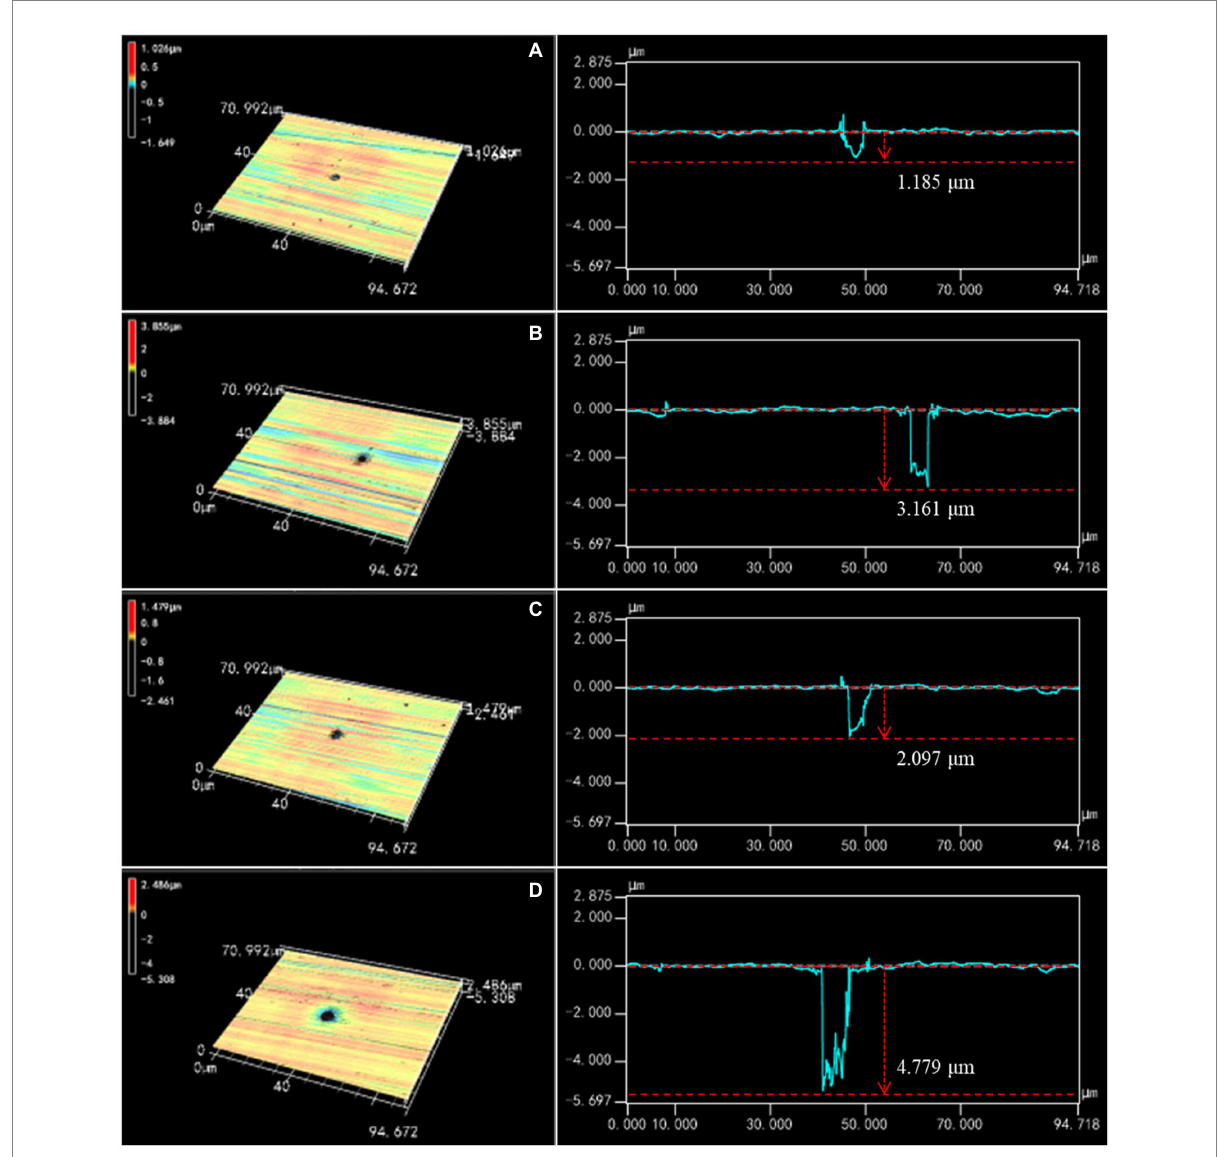
FIGURE 3 The characteristics of the largest pit found on the HEA coupon surface after immersion: sterile medium for (A) 7 days and (B) 14 days; P. aeruginosa -inoculated medium for (C) 7 days and (D) 14